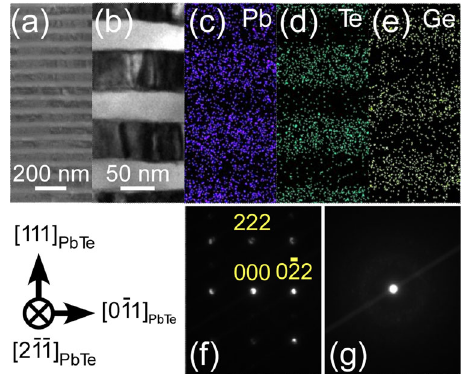
Fig. 2 Transmission electron microscopy results of a-GeS/e-PbTe superlattice. a Low-magni fi cation cross-sectional bright- fi eld transmission electron microscope (TEM) image of a-GeS/e-PbTe superlattice (SL). b High-magni fi cation cross-sectional scanning TEM (STEM) image, c – e Energy dispersive X-ray spectroscopy (EDX) mapping images of c Pb, d Te, and e Ge in the same region of a-GeS/e-PbTe SL. f , g Selective area electron diffraction (SAED) patterns of f black and g white regions in a- GeS/e-PbTe